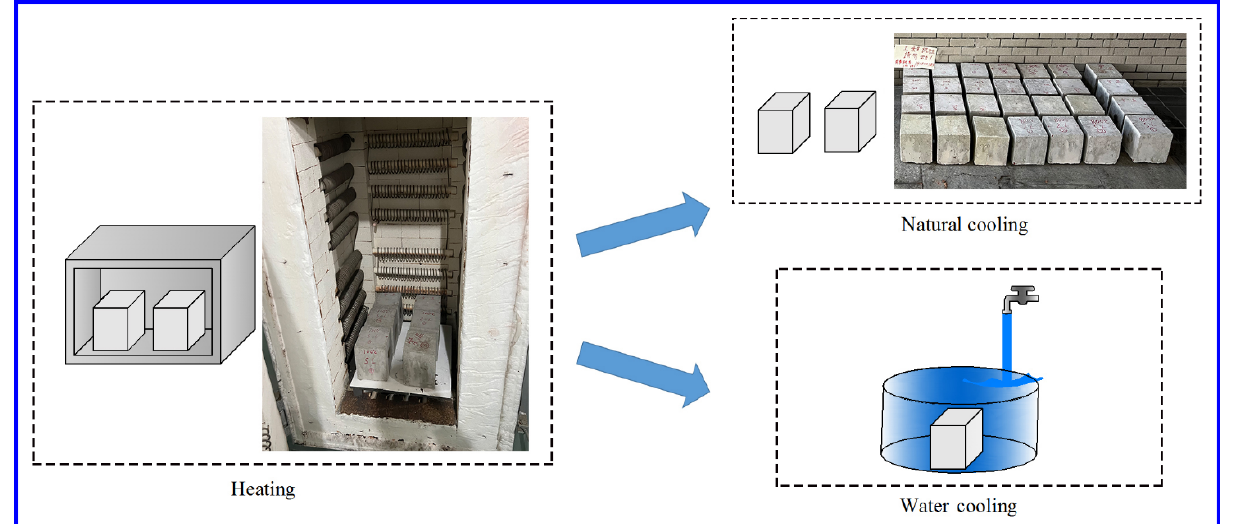
Figure 2. Heating and cooling of SCC specimens.